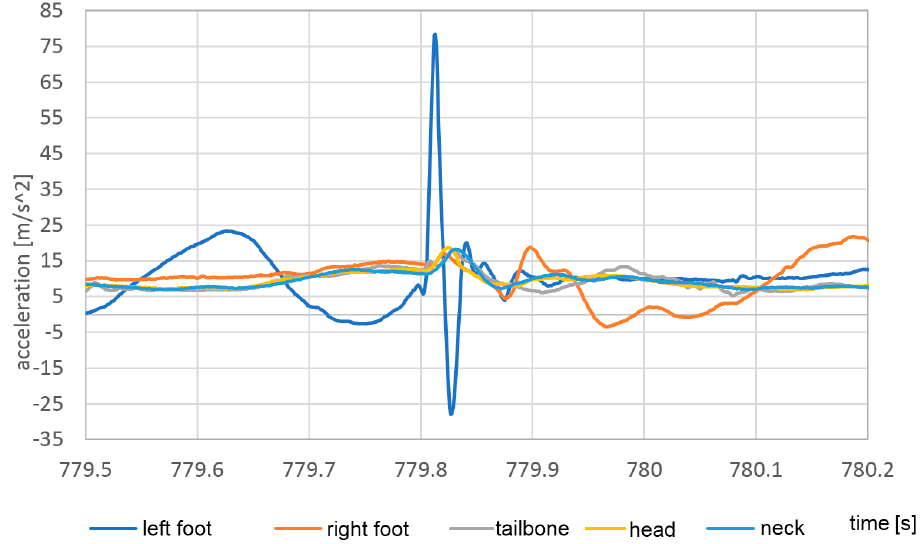
Figure 32. The vertical response of the sensors during the single impact of the bare right foot onto a hard surface. hard